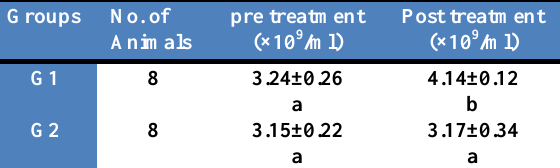
Table, 3: Effect of cumin seeds on sperm concentration. (M ±SE). Groups No. of